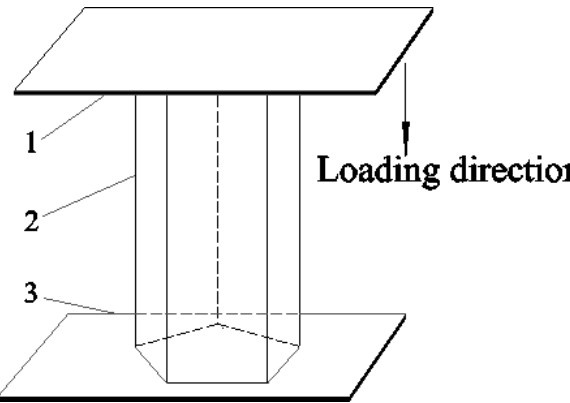
Figure 3: Mount and fixture of specimens: 1.Moving rigid platen;